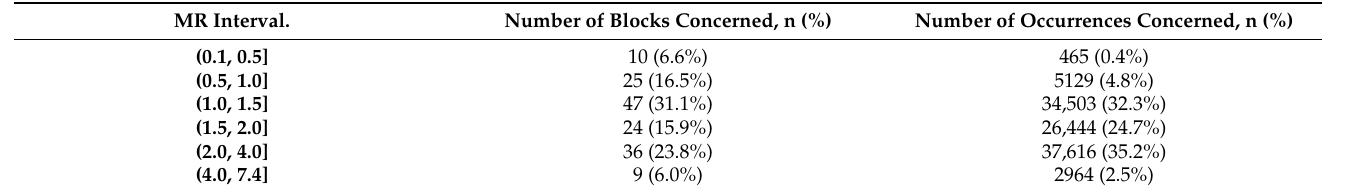
Table 1. Distribution of the MR indicator for the 151